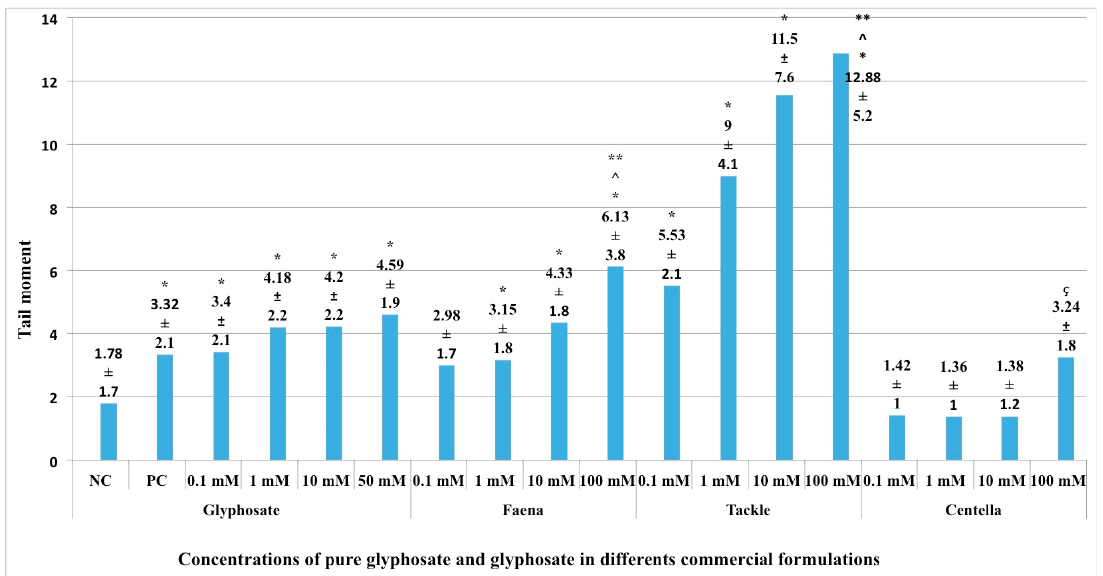
Figure 2. Tail moment parameter. Genetic damage in blood cells exposed to different concentrations of G and in three commercial formulations. Note: G in each CFG was calculated according to informative paper, so the evaluated concentrations of G were similar to G. NC, negative control (phosphate buffer), PC, positive control (10 mM EMS). * Statistical difference with respect to NC ( p < 0.05). ^ Statistical difference of G 50 mM with respect to FAENA 100 mM and TACKLE 100 mM ( p < 0.05). ** Statistical difference between FAENA 100 mM and TACKLE 100 mM ( p < 0.05). ç Statistical difference of CENTELLA 100 mM with respect to FAENA 100 mM and TACKLE 100 mM ( p < 0.05).